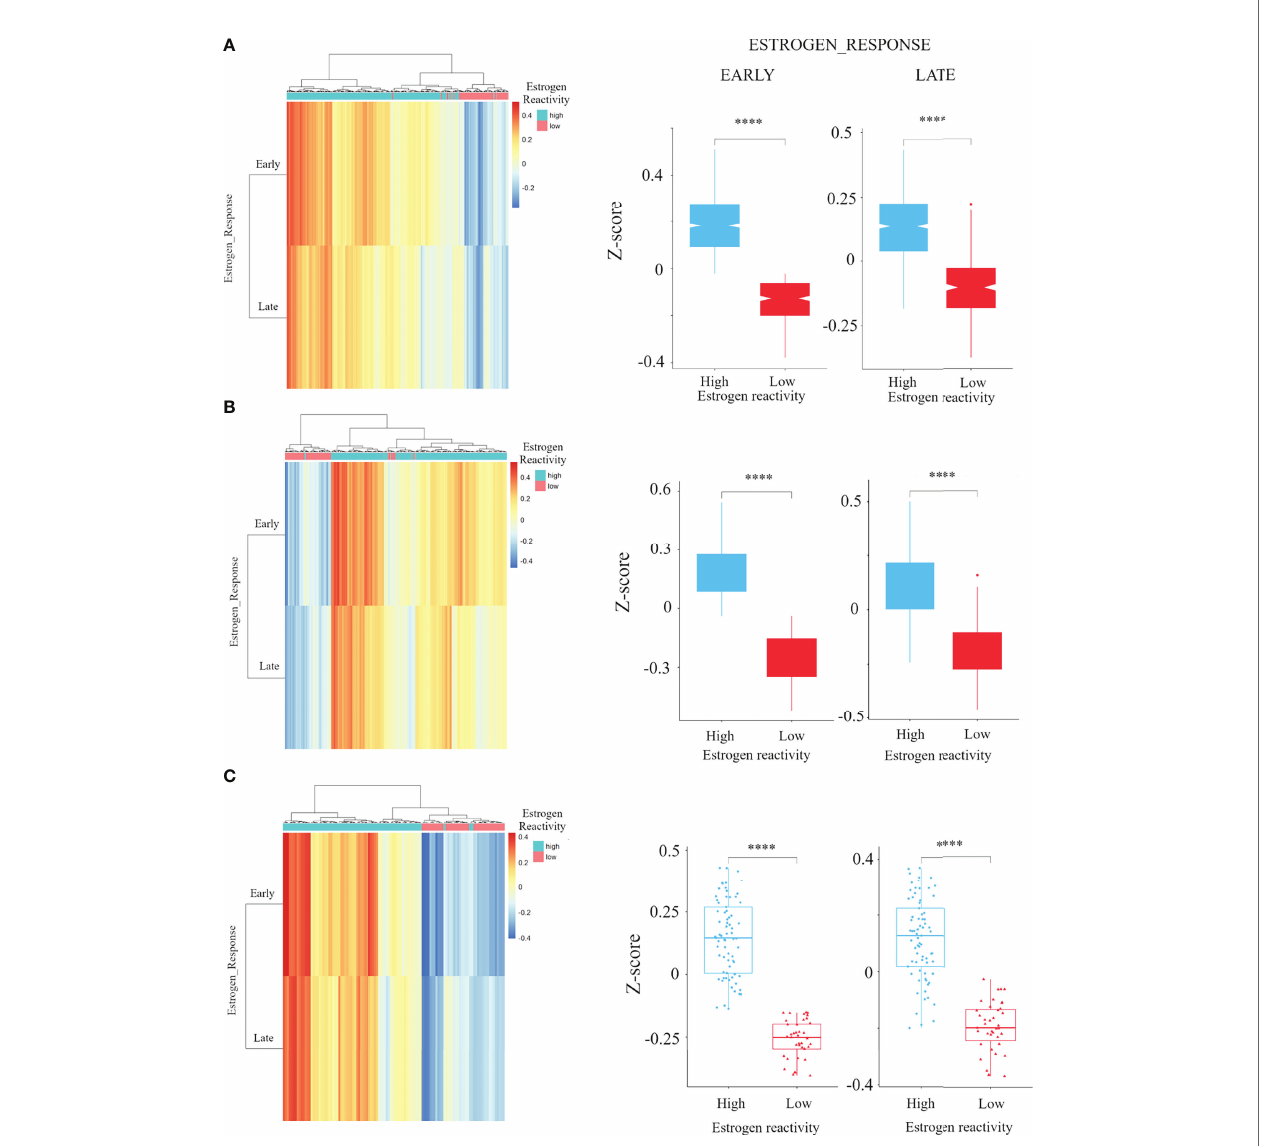
FIGURE 1 | The association of estrogen reactivity and estrogen response scores in GSVA. Heatmaps and boxplots of the comparison of estrogen response early and late score by estrogen reactivity in the METABRIC cohort (A) TCGA cohorts (B) and our cohort (C) were shown. In heatmap, the scores of ESTROGEN_RESPONSE_ EARLY and ESTROGEN_RESPONSE_LATE are displayed as colors ranging from red to blue as shown in the key. Both rows and columns are clustered using correlation distance and average linkage. **** means P < 0.0001. GSVA, Gene Set Variant Analysis; ER, estrogen receptor; PgR, progesterone receptor; METABRIC, Molecular Taxonomy of Breast Cancer International Consortium; TCGA, The Cancer Genome Atlas; HR, hormone receptor; HER2, human epidermal growth receptor 2; TN, triple